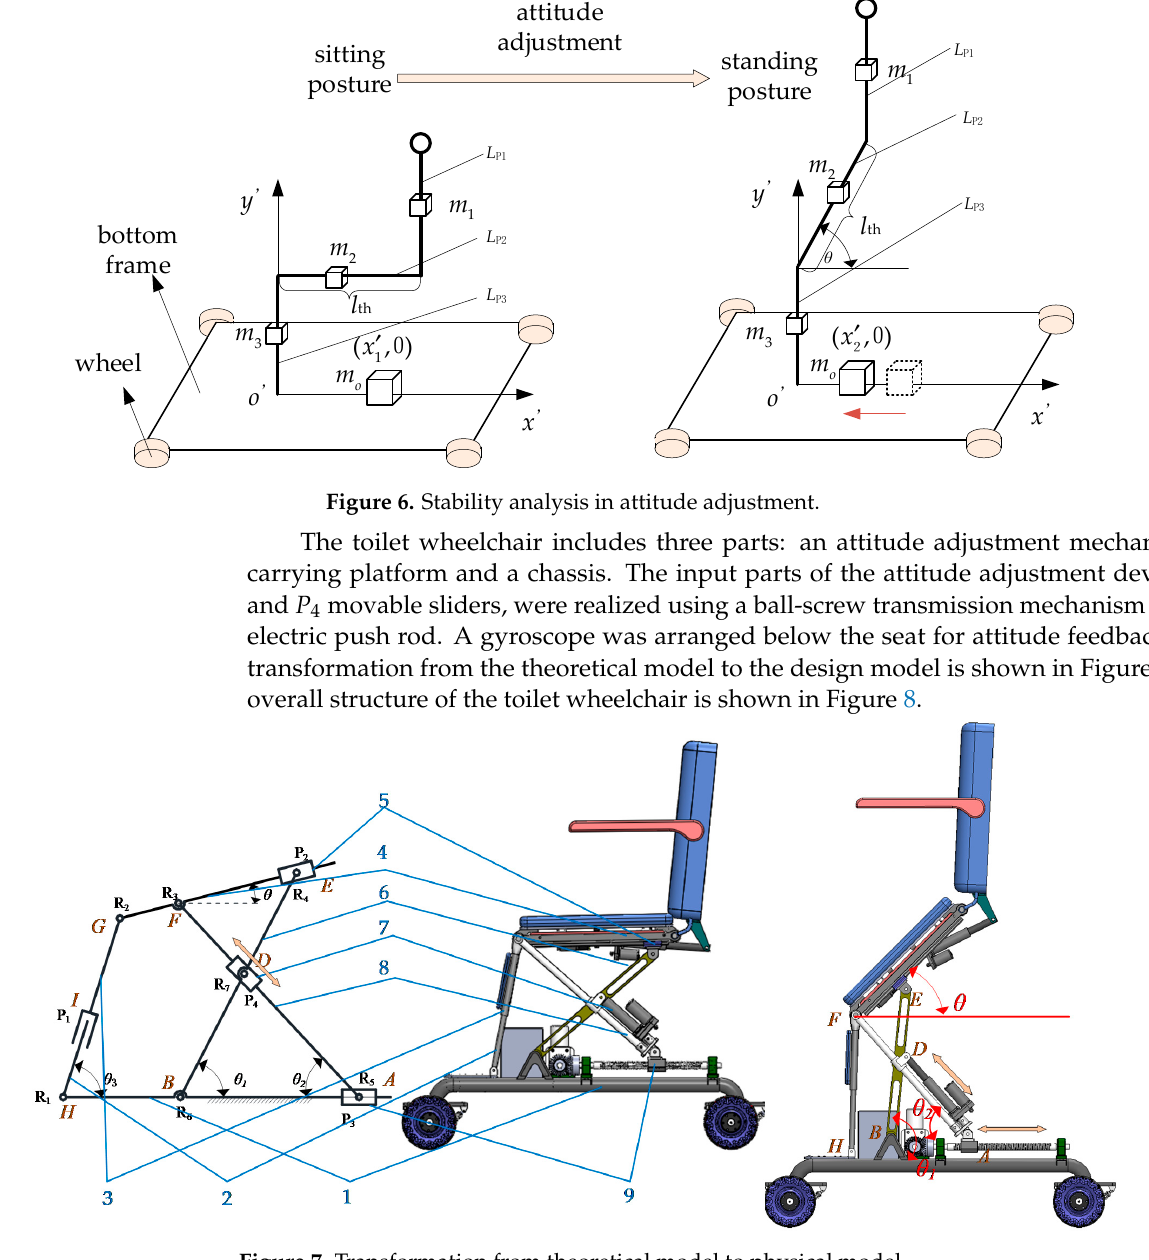
Figure 7. Transformation from theoretical model to physical model.